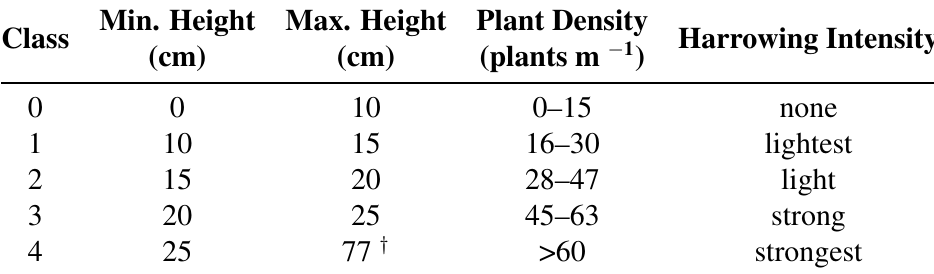
Table 1. Ranges of measured plant height in the field experiment, which correspond to each of the five discrete classes in the Decision Support System to control the harrowing